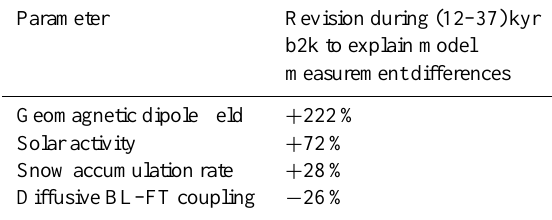
Table 1. Required revision of model input records to account for the (normalized to Holocene) model–measurement differences dur- ing (12–37) kyrb2k (30% of the observed Holocene mean, com- bined GRIP–GISP2 record). Note that, different to the geomagnetic dipole strength and the Greenland snow accumulation rate, the orig- inal model input parameters for solar activity and the diffusive BL– FT do not vary on a multi-annual